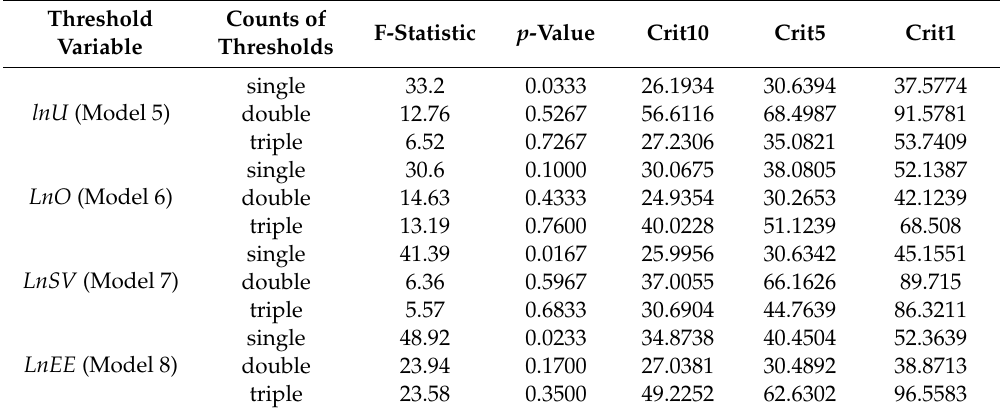
Table 6. Threshold e ff ect test results for each threshold variable.